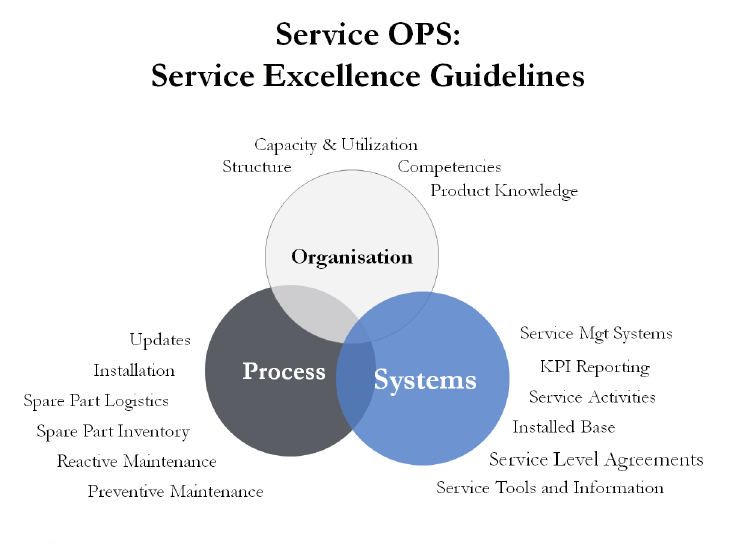
Fig. 3 – Service excellence. Source: